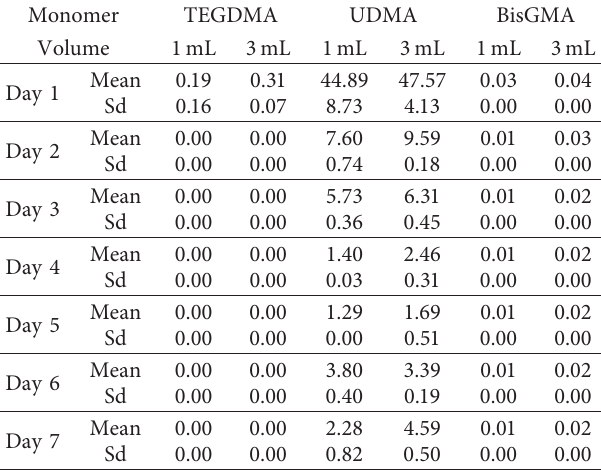
Table 4: Daily release of monomers from FBF ( µ g).